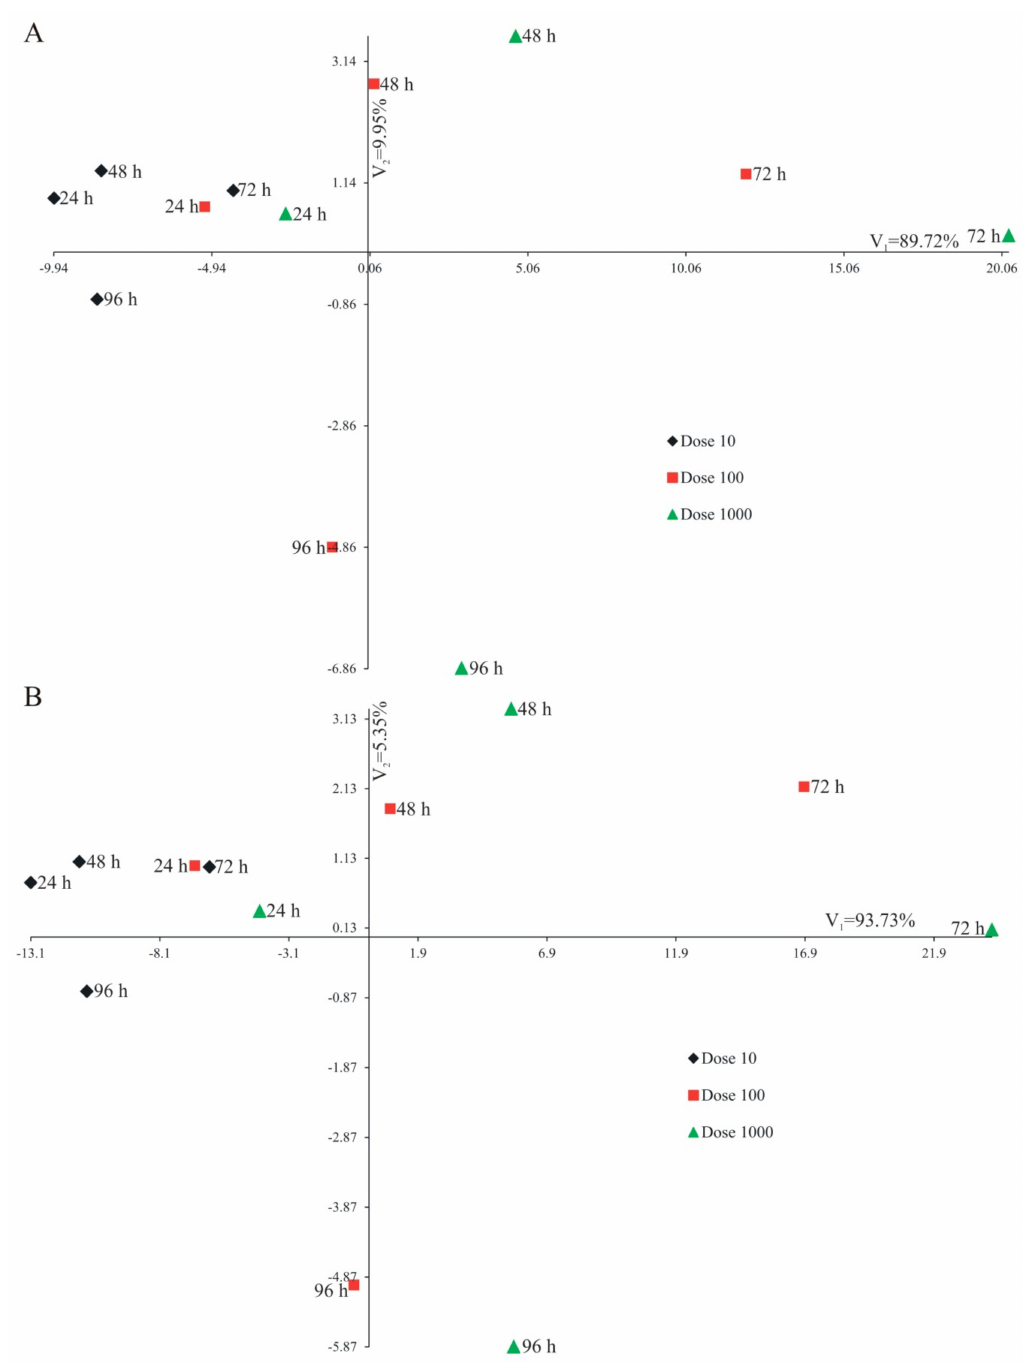
Figure 1. Results of a canonical correlation analysis of two parameters (time of GLV collection and stimulant doses) on VOCs emission levels, where ( A ) refers to ZJA and ( B ) refers to DJA